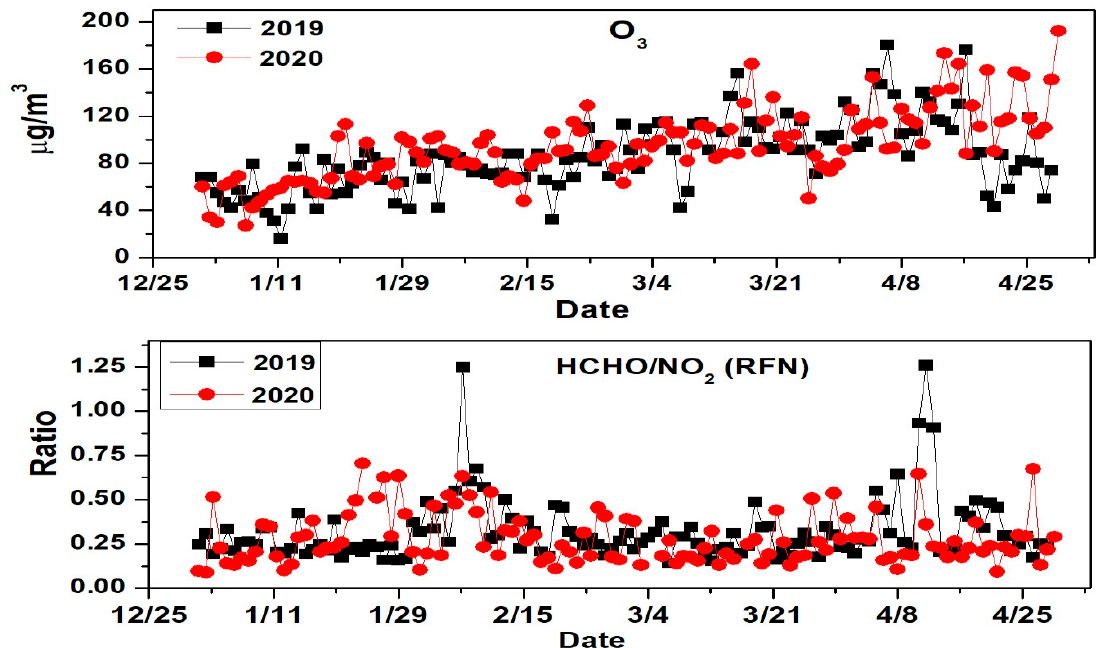
Figure 10. Ozone (O 3 ) measurements over Shanghai for the study period. Daily averaged HCHO/NO 2 ratio (RFN) at Shanghai.